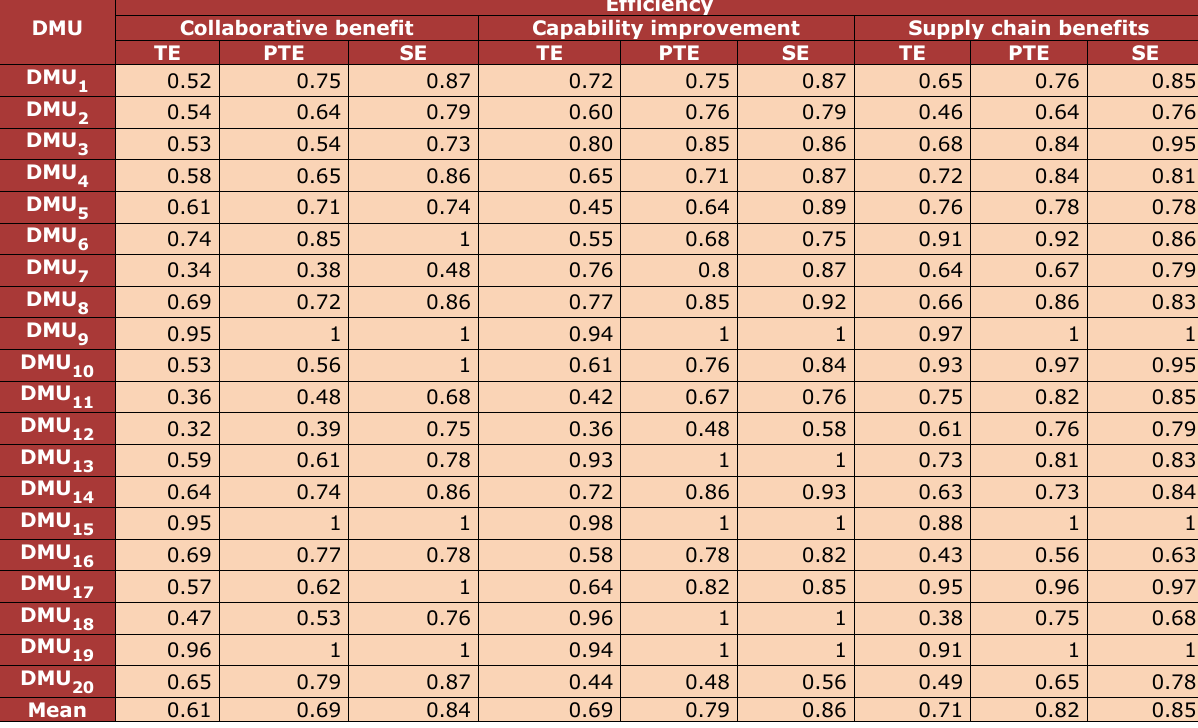
Table 4. The comprehensive technical efficiency of three years (from 2012 to 2014) DMU